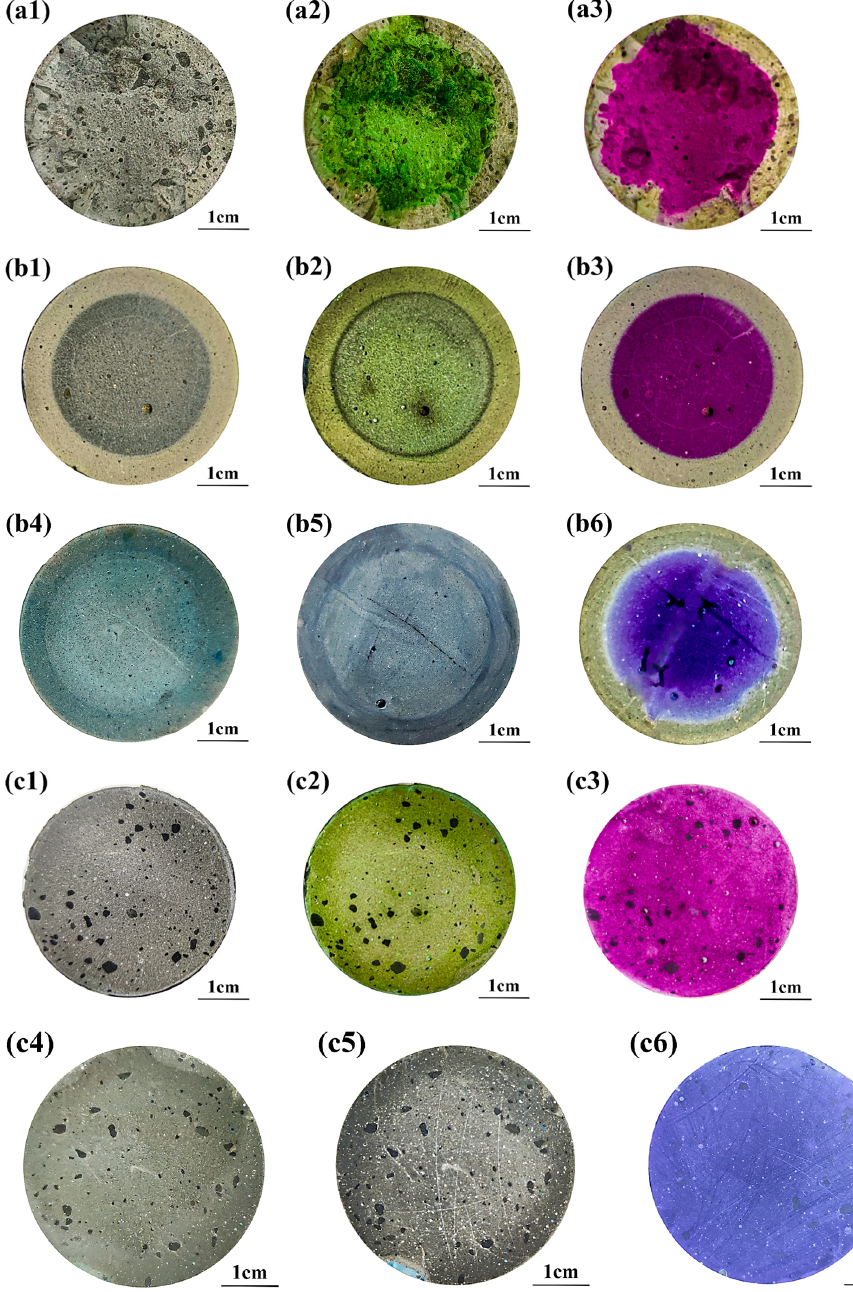
Figure 6. Partly neutralized sample before and after pH indicator spray. ‘ a ’, ‘ b ’, and ‘ c ’ stand for partly carbonated, leached, and sulfate-attacked sample, respectively; suffix ‘ 1 ’, ‘ 2 ’, ‘ 3 ’, ‘ 4 ’, ‘ 5 ’, and ‘ 6 ’ stand for specimens before spraying and spraying with anthocyanin, phenolphthalein, malachite green, indigo carmine, and thymolphthalein, respectively.